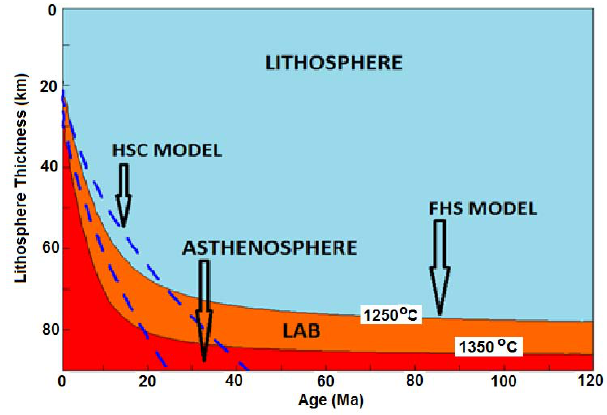
Fig. 4. Variations in the thickness of the oceanic lithosphere with age, according to the finite half-space (FHS) model, for the case of basal geotherms of 1250 ◦ C and 1350 ◦ C. Also included here is a comparison of the variations in the thickness of the oceanic lithosphere with age, according to the finite half-space (FHS) and half-space cooling (HSC) models. The dashed curves in this figure indicate depths of LAB in the HSC